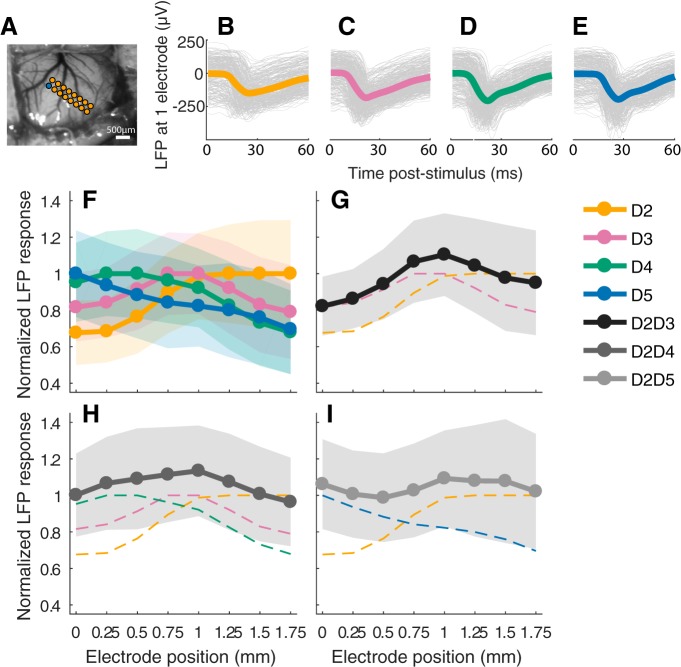
Example of S1 layer 4 LFPs recorded during single- and two-digit stimulations. A, Location of the microelectrode array in S1. The blue dot represents the electrode at 0 mm. B–E, Single trials (gray) and average (colored thick line) LFP responses for all single digit stimulations (D2–D5) recorded from the electrode marked with the blue dot. F, Normalized mean area under the curve indicated as mean LFP response, according to recording electrode position (in millimeters). The colored transparent shapes indicate standard deviations. The spatial distribution of LFP responses was somatotopic, with each stimulation evoking a cortical activity profile gradually shifted along electrode position. G–I, Funneled cortical pattern of activity elicited by digit costimulation (thick solid lines), superimposed on that generated by single stimulation of the same digits (dashed lines).